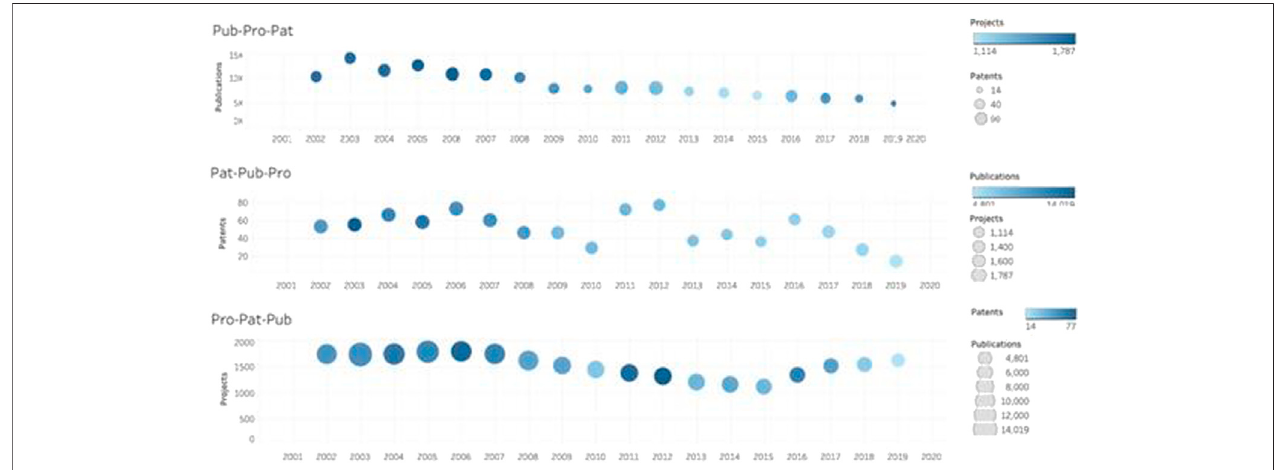
FIGURE1| Detailofthe interactive diagram map oftheevolutionofprojects, patents and publications, considered as layersofparalleloutcome processes ofUPC in the period 2002 – 2019. Source: Cavaller et al. (2020), Own elaboration based on Future UPC data with Tableau.